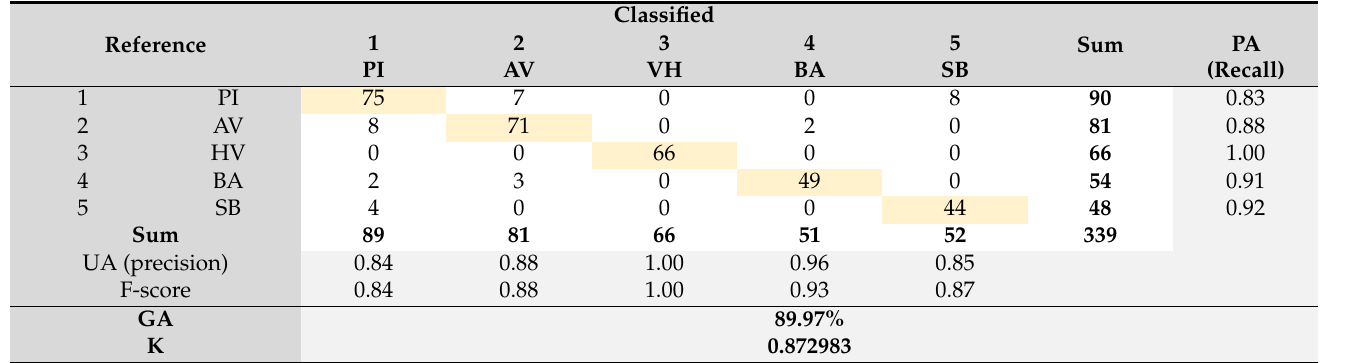
Table 9. Confusion classification matrix for the SAPIENS area. The rows represent the reference map, and the columns represent the classified map. The classes are 1— Pinus sp. (PI), 2—arboreal vegetation (AV), 3—herbaceous vegetation (HV), 4—marsh (BA), and 5—shade (SB). The table also includes the measures of producer accuracy or recall (PA), user accuracy or precision (UA), F-score, global accuracy (GA), and kappa Cohen index